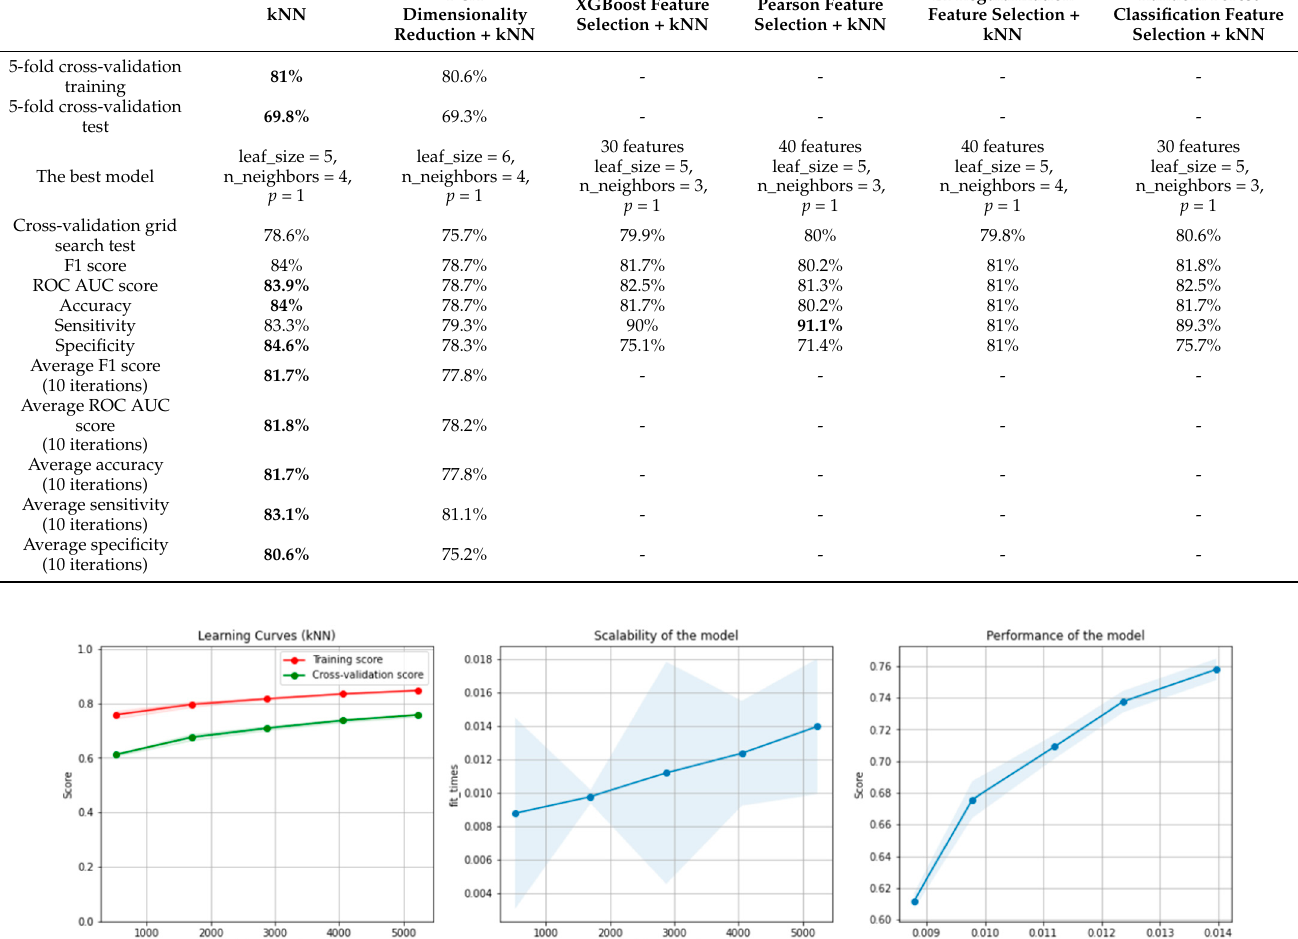
Figure 16. Learning curves, scalability and model performance for the kNN algorithm, for the overlapping dataset.